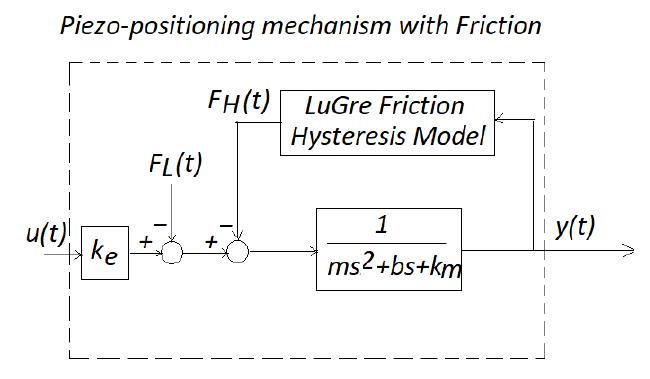
Figure 8. Model of a piezo-positioning mechanism with